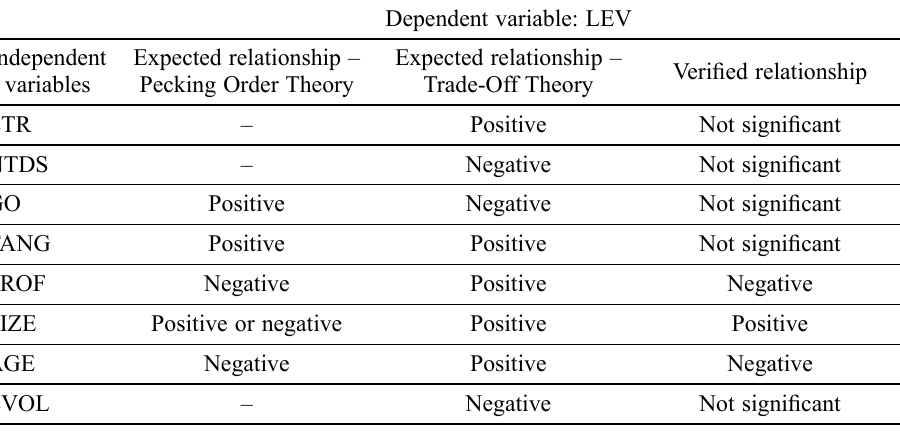
Table 5. Expected and verified relationships